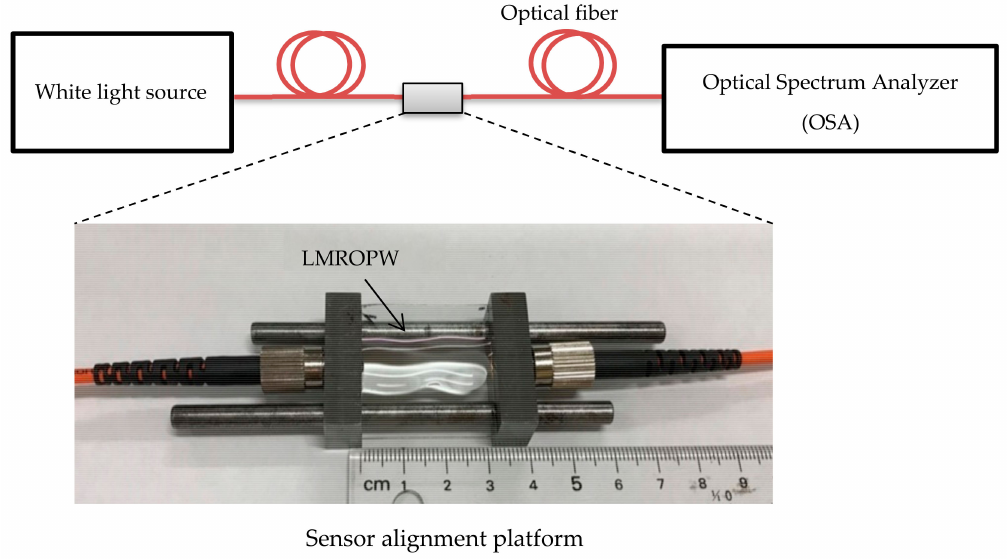
Figure 4. Measurement setup of the LMROPW sensor held with the alignment